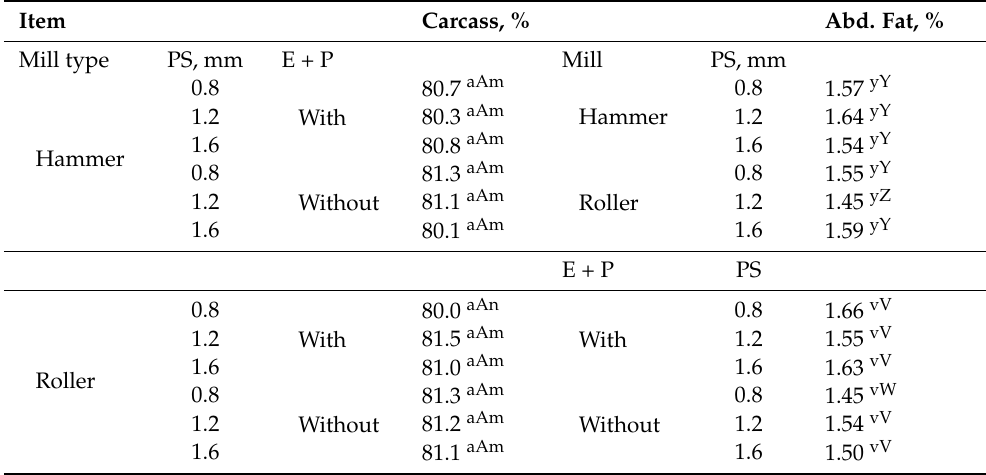
Table 8. Breakdown of significant interactions as presented in Table 7. Item Carcass, % Abd. Fat,